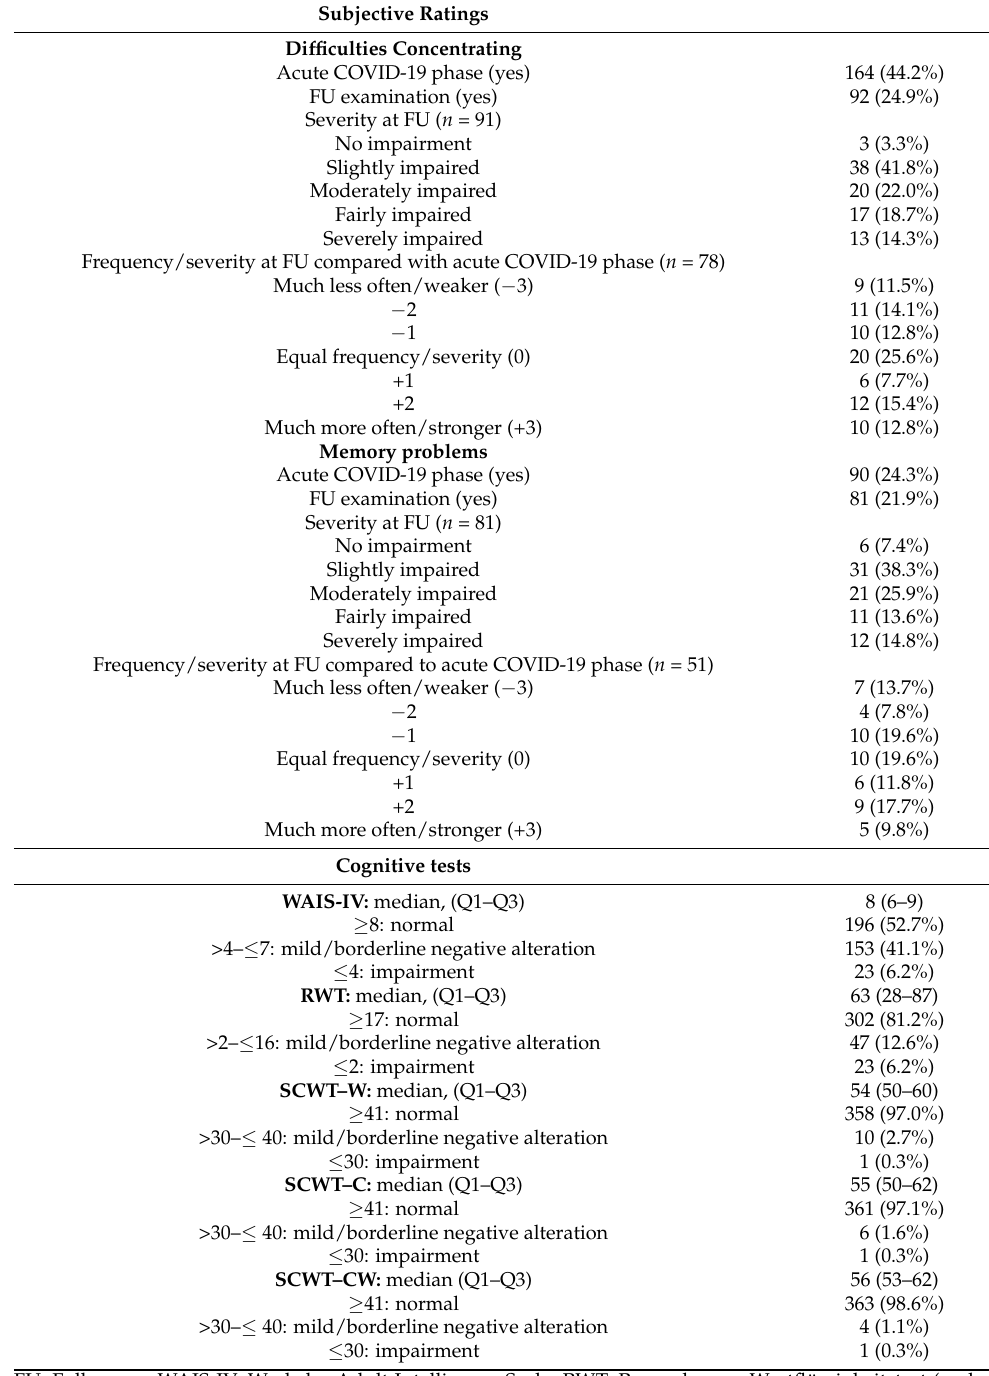
Table 2. Cognitive evaluation: results of subjective ratings of concentration and memory problems, and standard cognitive